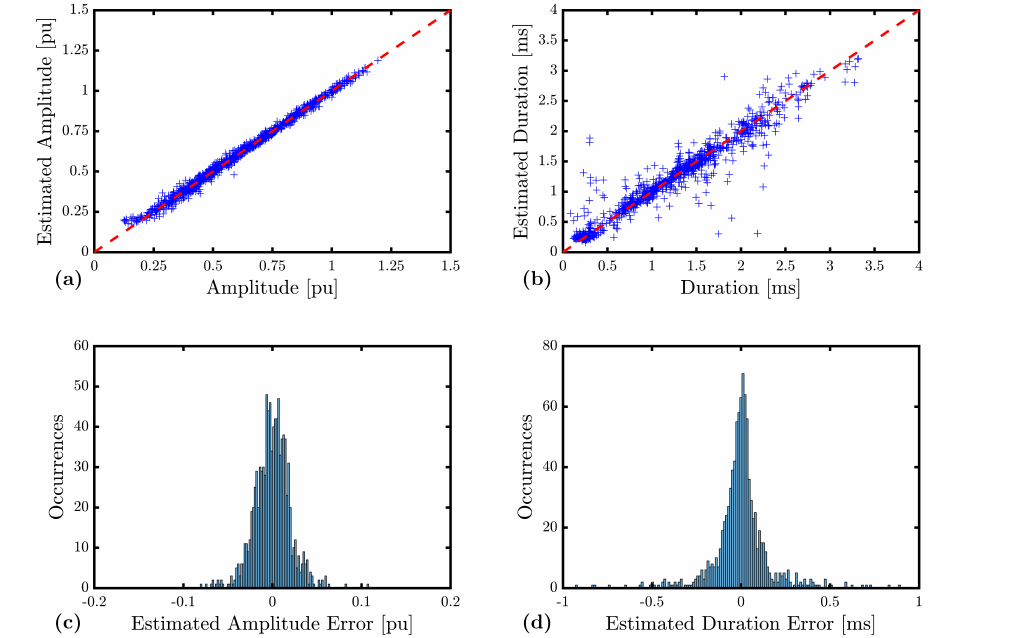
Figure 10. Test set results. In ( a ), the relation between the real transient amplitude (i.e., benchmark) and the proposed method’s estimated amplitude is shown while in ( b ), the corresponding relation for the transient duration is plotted. The histogram of the estimated transient amplitude error is shown in ( c ), and the estimated transient duration error is shown in ( d